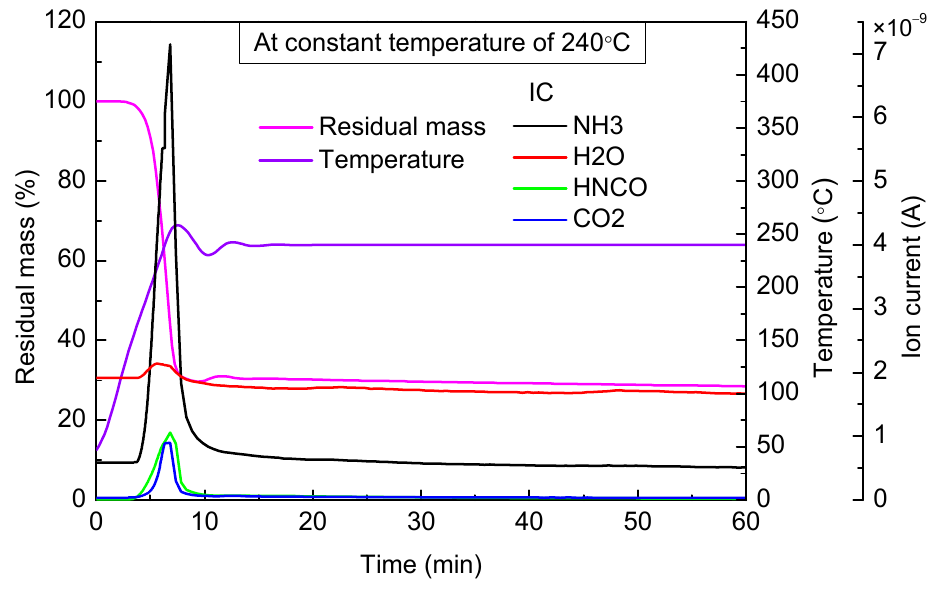
Figure 6. TG-MS results of urea at constant temperature of 240 °C.